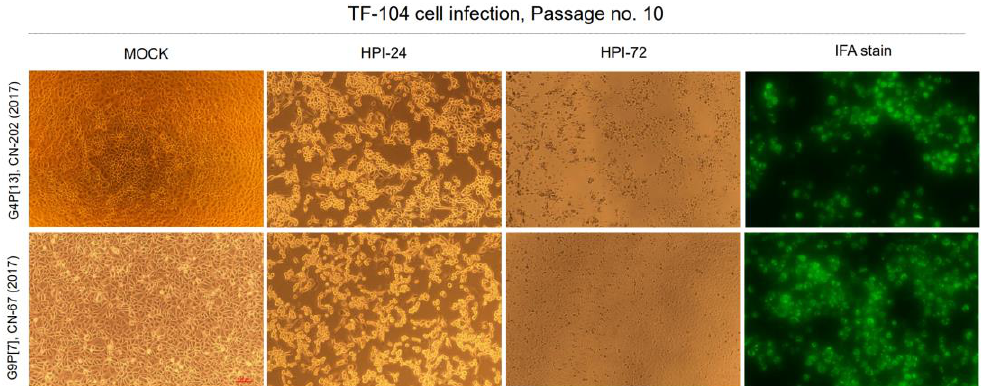
Figure 5. Isolation and detection of the PoRVA CN-202 (G4P[13]) and CN-67 (G9P[7]) strains in TF-104 cells. TF-104 cells were seeded in T-75 flasks and infected with 10th passage virus at a multiplicity of infection (MOI) of 0.1. Specific cytopathic effects were observed under a microscope at 24 – 72 h postinfection (hpi) (Mag x100). The immunofluorescence assay results for the PoRVA CN-202 (G4P[13]) and CN-67 (G9P[7]) strains (passage 10) in infected TF-104 cells at 20 hpi are shown (Mag x100).